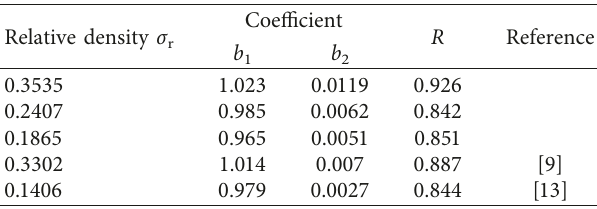
Table 2: The coefficients of relative plateau stress on equation (5) and relative density of